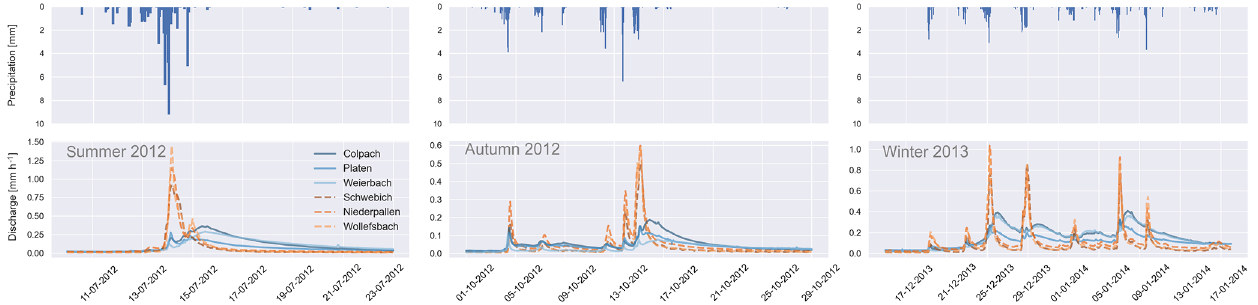
Figure 2. Observed specific discharge and precipitation with different ordinate scales for a time period in summer 2012, autumn 2012 and winter 2013 in the six catchments (orange: marl catchments; blue: schist catchments). This figure highlights that the two geological formations have a distinctly different hydrological function with respect to how they transform rainfall to runoff throughout the year.